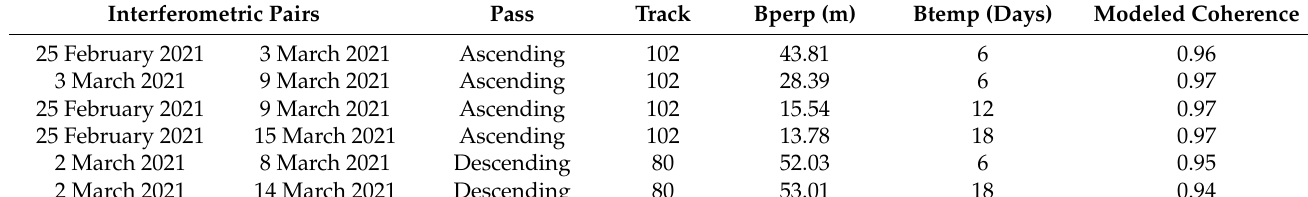
Table 2. Details of InSAR processing using Sentinel-1 data.